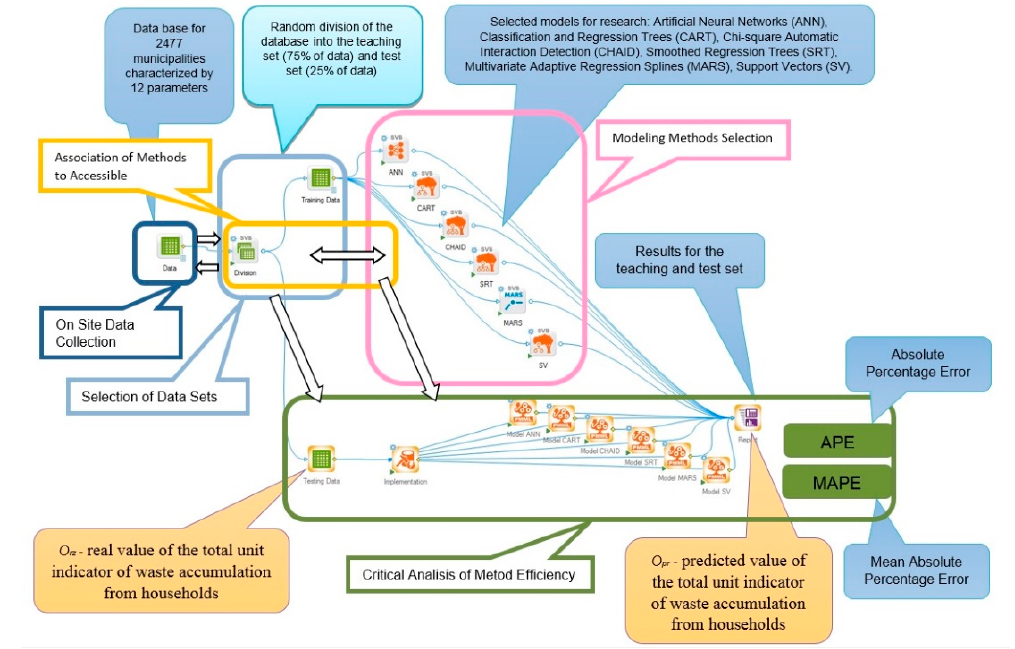
Figure 5. View of Data Miner working space.